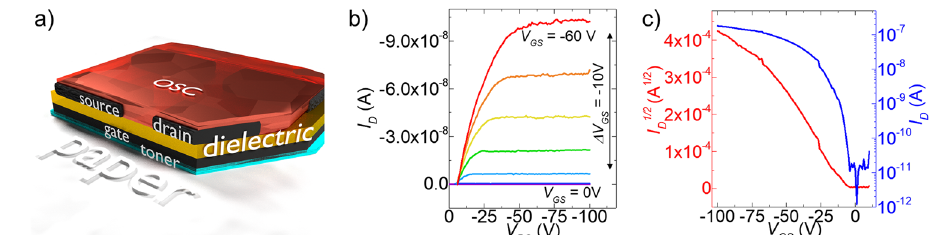
Fig. 5 I – V characteristics for a C8-BTBT semiconductor, mylar dielectric graphite spray device. a Schematic of bottom-gate, bottom-contact device on paper. Here, OSC is C8-BTBT, dielectric is mylar, and the source, drain, and gate are graphite. b Transport curves. The lines are colored by the voltage applied at the gate as the source – drain voltage is modulated. c Transfer curve for this device. The left y axis shows the square root of the drain current, the right y axis shows the drain current plotted on a logarithmic scale in blue with a V DS of − 50